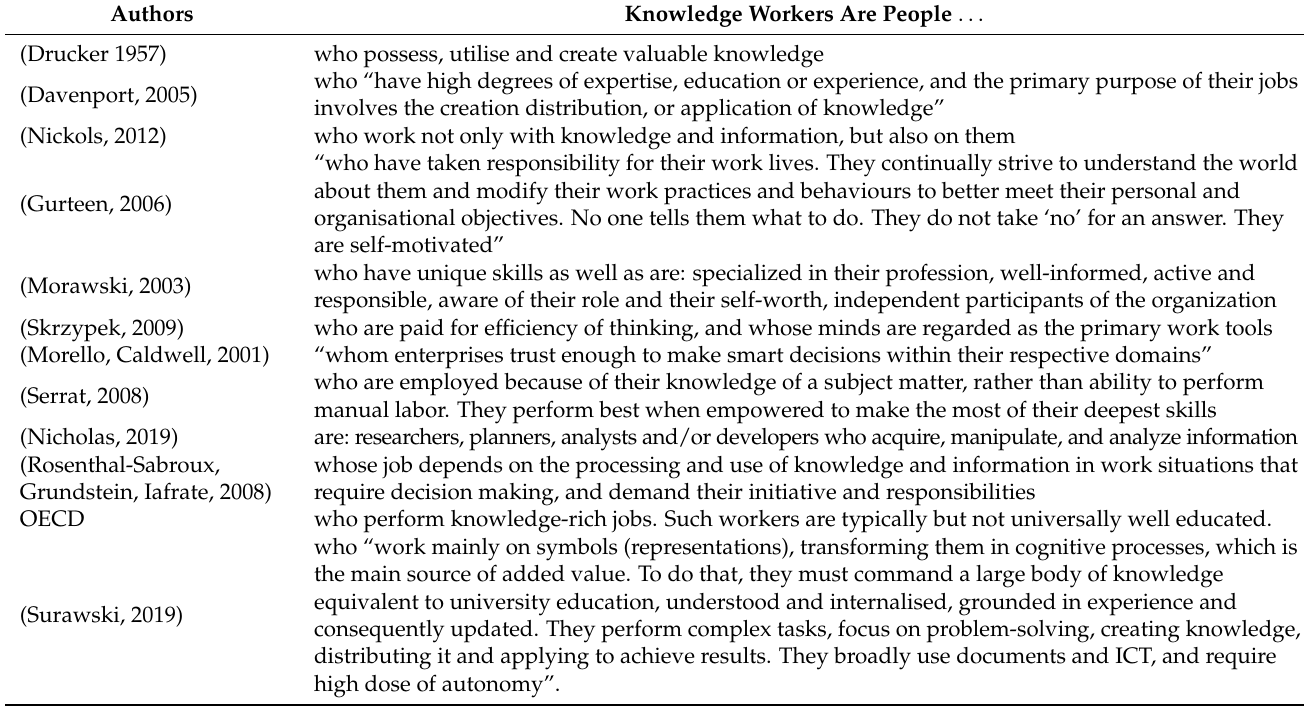
Table 2. Definitions of knowledge